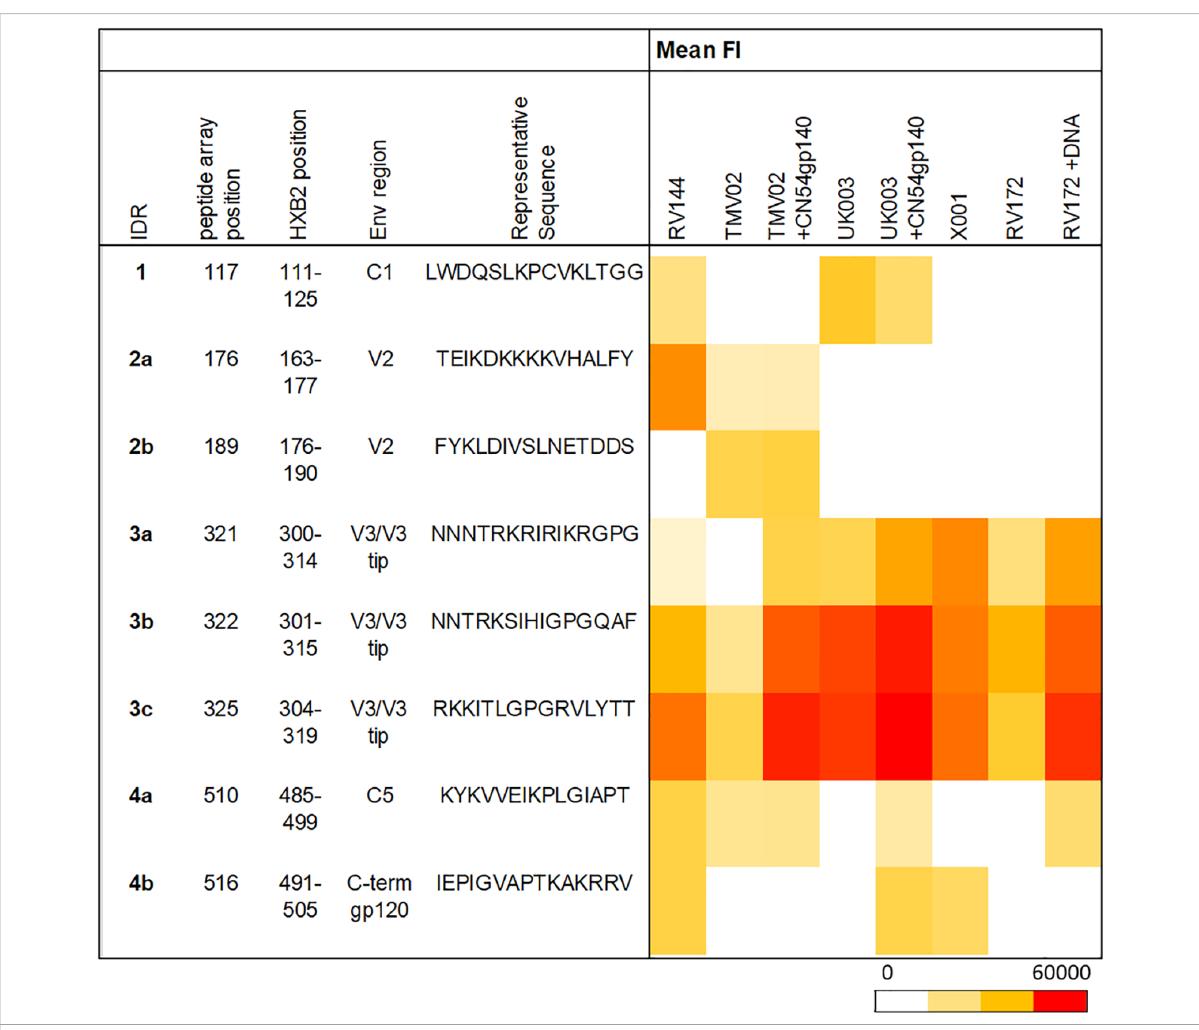
TABLE 1 Summary of immunodominant antigenic regions (IDR ’